Question: What type of chart is this?
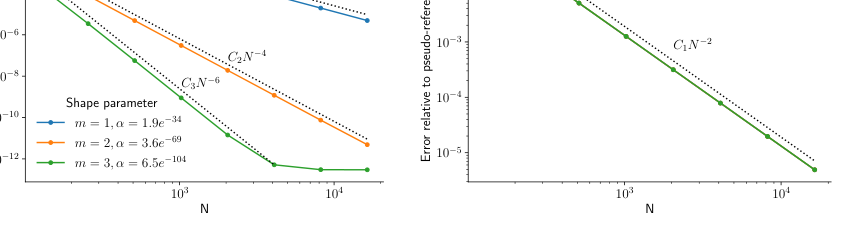
Answer: line